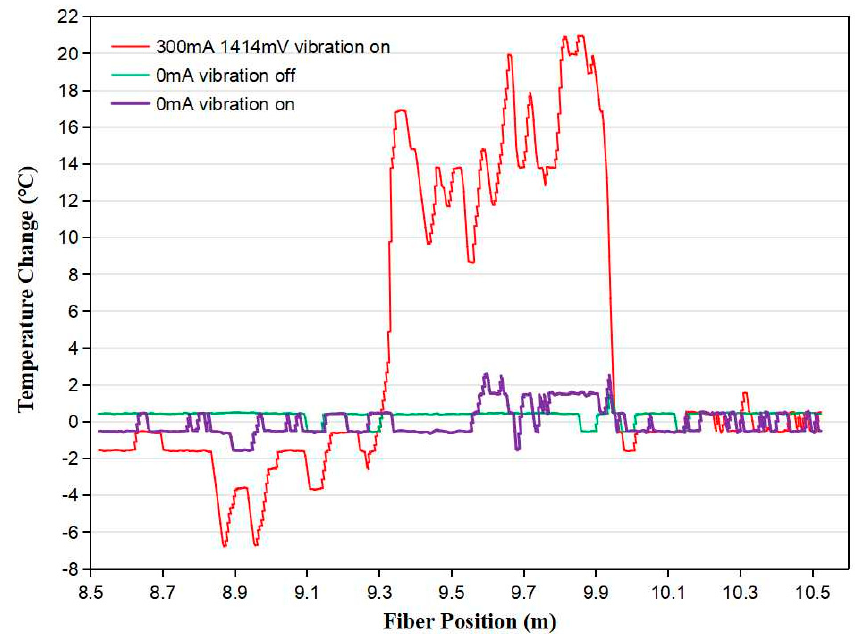
Figure 7. Noise—i.e., temperature fluctuation—induced in the sensing fiber without car engine vibration (green line), the noise induced with car engine vibration (purple line), and the signal strength increase caused by heating the sensing fiber (red line).